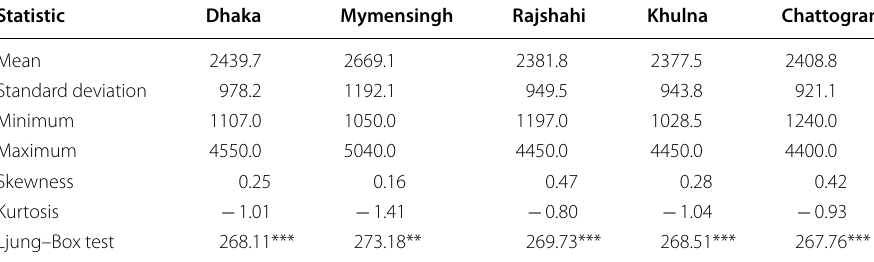
Ljung–Box test is the null hypothesis of time series containing an autocorrelation ***Denotes statistical significance at the 1% critical level